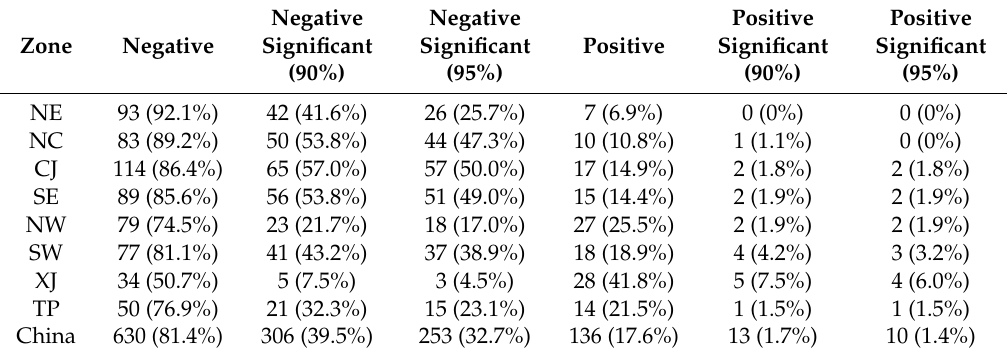
Figure 8. The spatial distribution of the stations displaying negative or positive CI trends across China. ( a ) The overall station trends (The blue downward triangles denote decreasing trends; the red upward triangles denote increasing trends) and ( b ) the stations exhibiting statistically significant trends (The blue circles denote decreasing trends, the red circles denote increasing trends, the bigger circles show trends exhibiting a 95% significance level detected by the MK test, and the smaller circles show trends exhibiting a 90% significance level detected by the MK test). Table 2. CI trends obtained by the Mann–Kendall for all subregions in China.